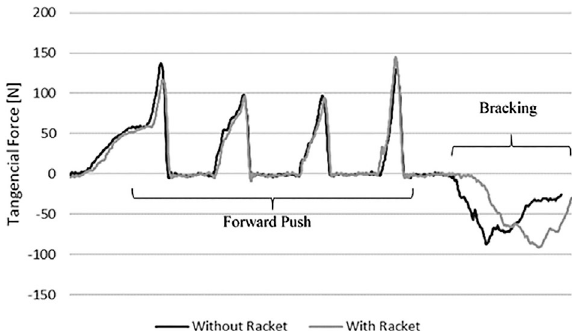
Figure 1 - Self-selected velocity in freehand (without racket) and holding racket (with racket) conditions.